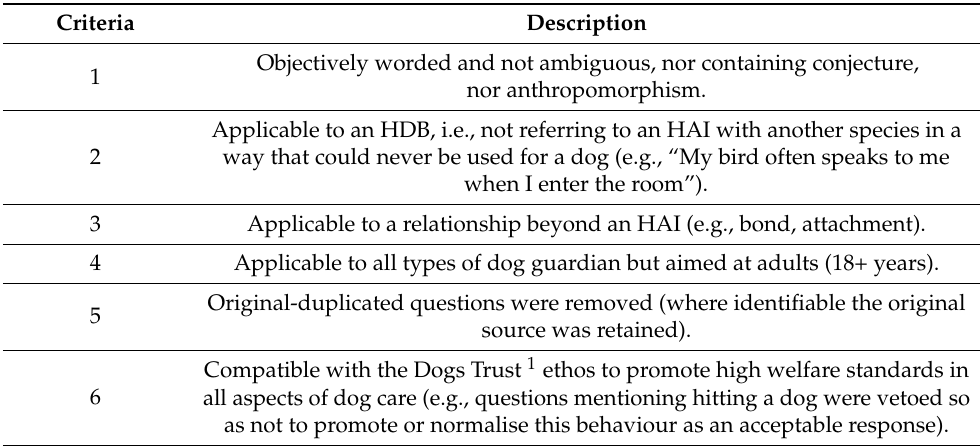
Table 2. The suitability criteria that HAI tool questions had to meet for assessing the human–dog bond